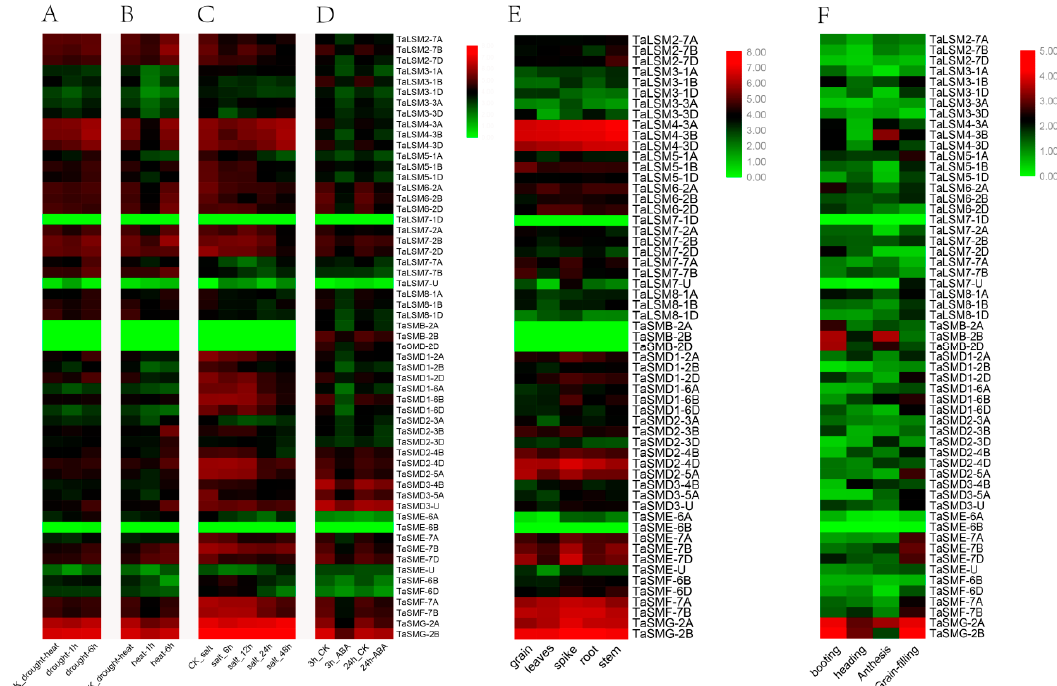
Figure 6. The expression profiles of SSM/SLSM in four stress treatments, five different tissues, and four different devel- opment stages in bread wheat. The expression profile in ( A – D ) for four different stress, respectively, including drought, hot, salt and ABA. The expression profile in ( E ) for five different tissues, and ( F ) four different development stages. Base on the results, we selected eight genes (SMD1-6D, SMD1-2D, SMD1-2A, SMD2-5A, SMF-6B, LSM5-1D, LSM7-7A, LSM8-1A) to further validate their expression profiles by qPCR (Figure 7). We found the SMF-6B, LSM7-7A, SMD1-2A, and LSM8-1A in salt and drought stresses were highly expressed, which indicated that such genes may play more important roles in wheat drought and salt resistance.